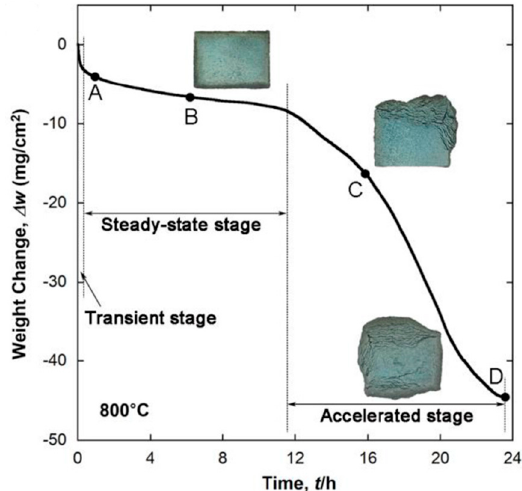
Figure 13. Isothermal oxidation curve of the Mo–30Ti–17Si–5B–10C (at.%) alloy oxidized at 800 °C, along with the appearance of the oxidized specimens [66].